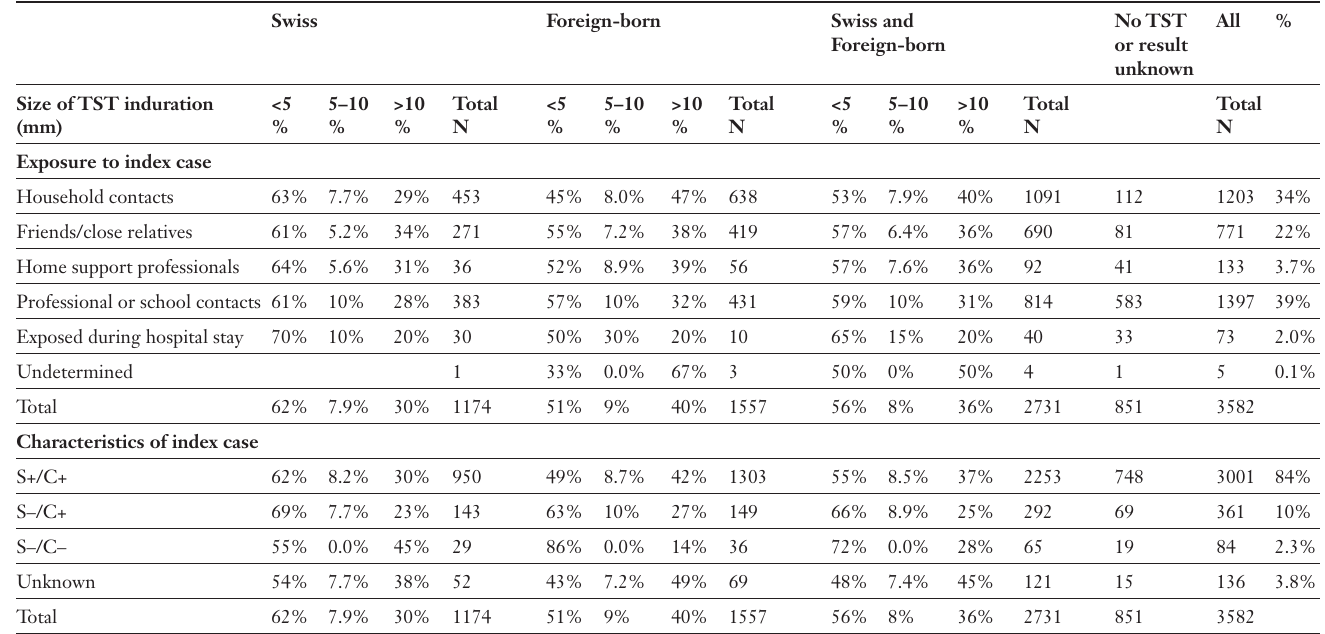
Results of tuberculin skin tests (TST) according to exposure to index case and bacteriological status of index case. S+/C+ : smear positive and culture positive; S-/C+: smear negative and culture positive; S-/C-: smear negative and culture negative